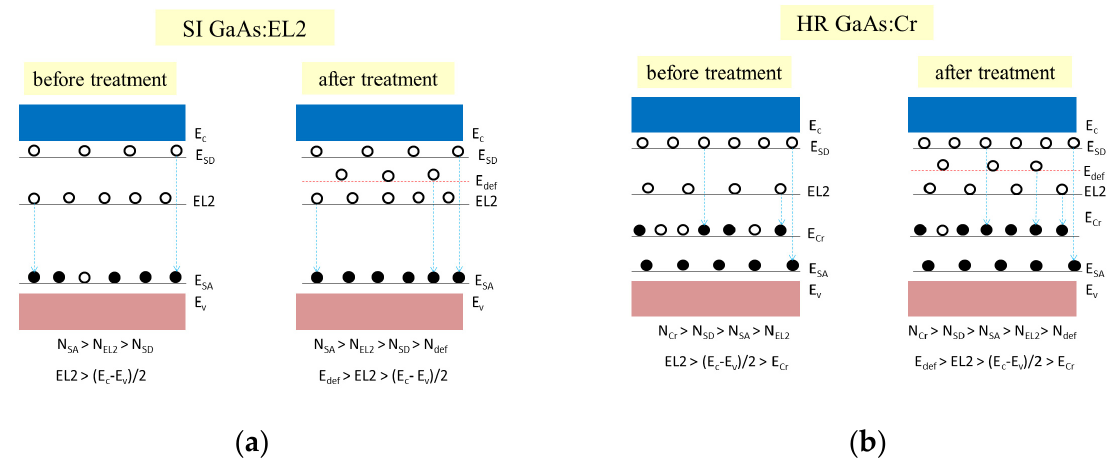
Figure 4. Energy level diagrams of ( a ) SI GaAs:EL2 and ( b ) HR GaAs:Cr before and after the mechanical treatment. The transitions at redistribution of electrons on the energy states are shown with arrows.